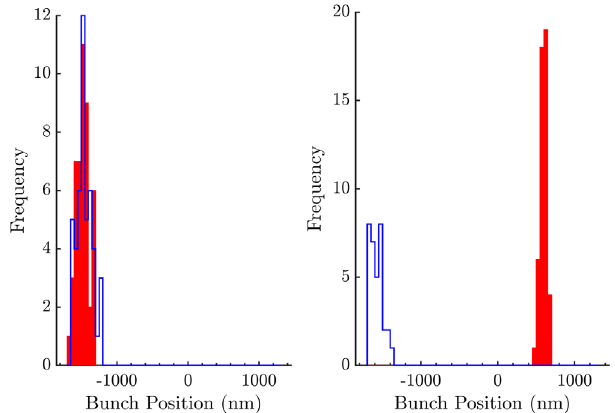
FIG. 18. Distributions of bunch-1 (left) and bunch-2 (right) positions measured at IPB, with feedback off (blue) and feedback on (red). Feedback was performed in 2-BPM mode, stabilizing at IPB using beam position measurements from IPA and